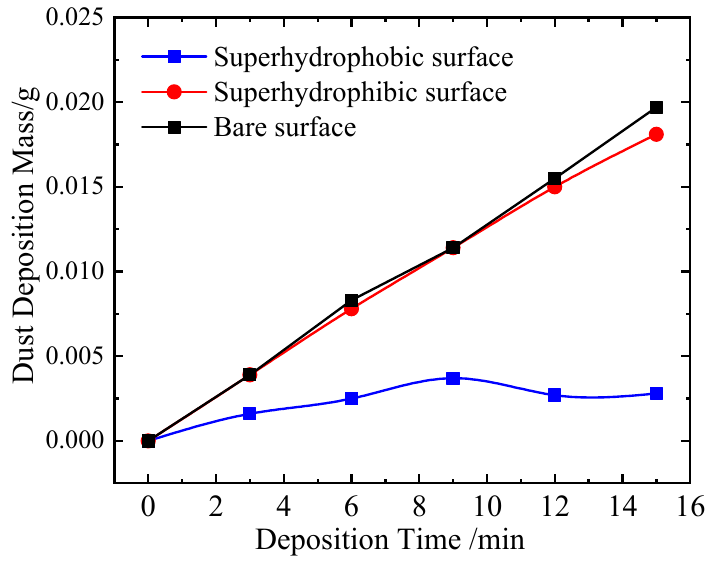
Figure 6. Dust deposition mass on solar cell covering glass with and without coatings. Figure 7. Dust deposition mass on solar cell covering glass with and without